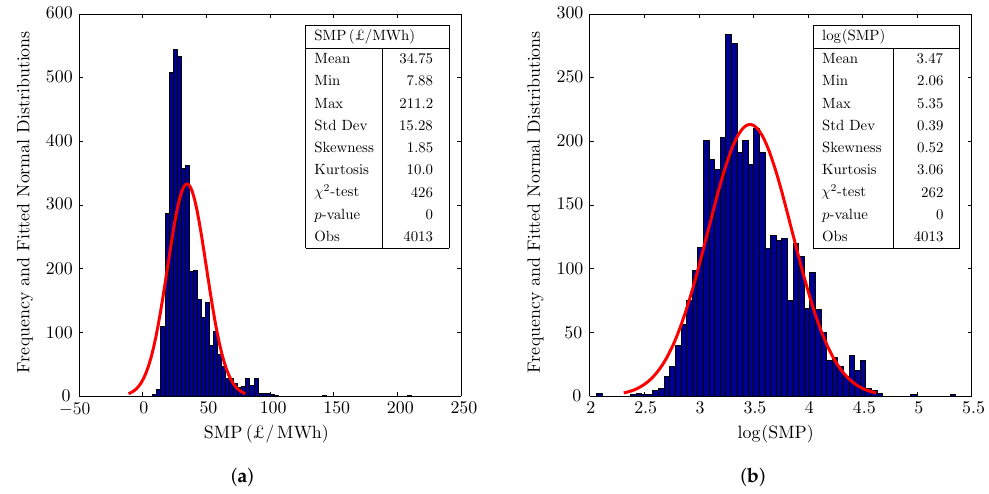
Figure 3. Distribution of SMP in ( a ) and distribution of log(SMP) in ( b ) of the peak-demand period over trading days (1 April 1990–26 March 2001). Author’s calculations. Notes: The empirical distribution (in blue) does not match the fitted normal distribution (in red), which is also confirmed by the χ 2 goodness of fit test rejecting the null hypothesis of normal distribution. We also find that the empirical distribution is skewed to the right (because skewness is positive) and has excess kurtosis (because kurtosis is above three). For the normal distribution, the values of skewness and kurtosis are zero and three, respectively.